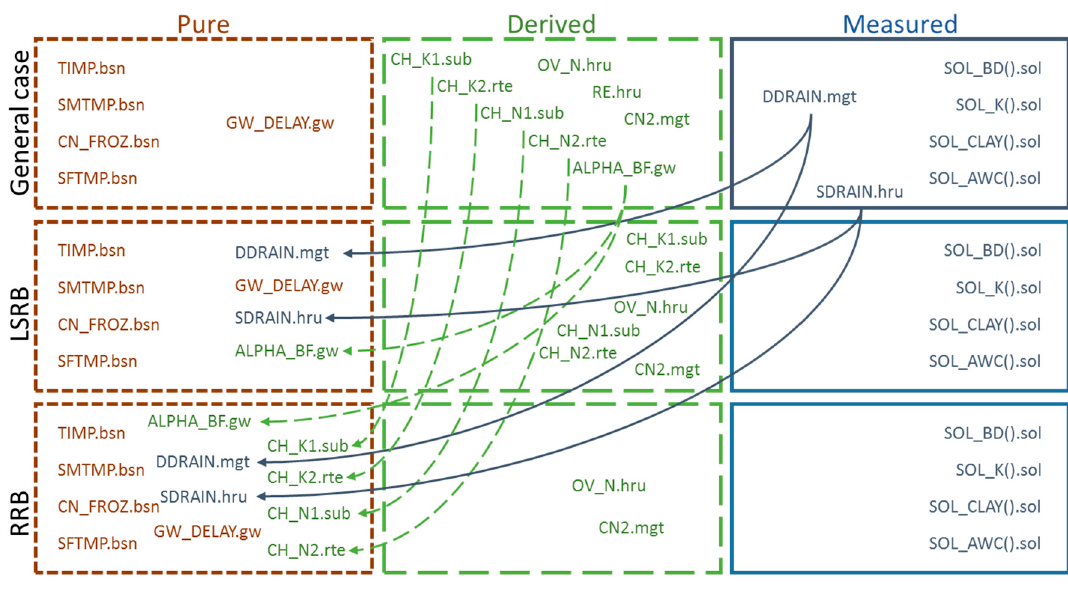
Figure 2. Flexible nature of parameter classification. All parameters with the extension .bsn are specified at the spatial resolution of the entire watershed, all parameters with the extension .sub or .rte are specified at the spatial resolution of the subbasin and all other parameters are specified at the resolution of the hru. All parameters were described in a distributed setting. For example, CN2 was specified for each hru based on land use, soils type and condition. The parameters are defined in Table S1 in the SI.